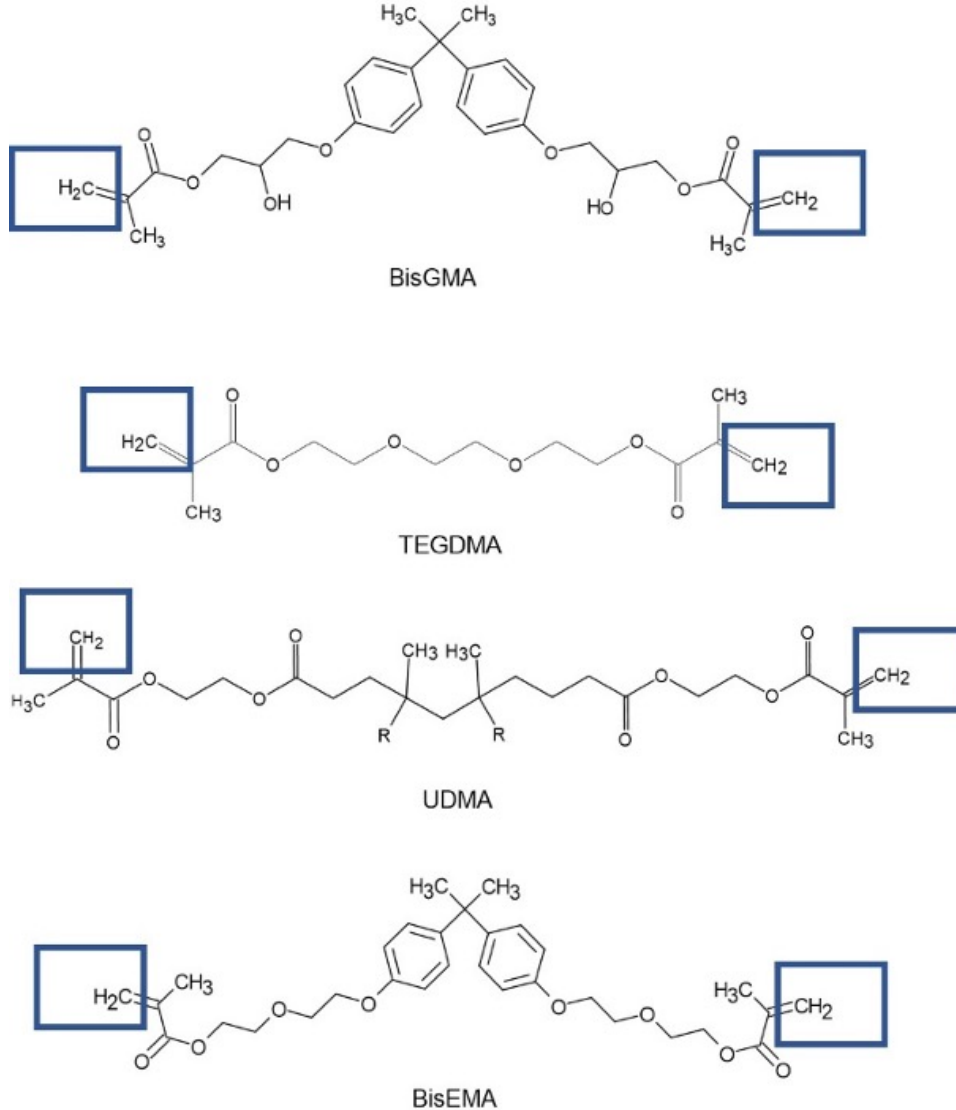
Figure 7. Chemical formulae of the resins included in the composites with the denoted bonds involved in the photopolymerization process.